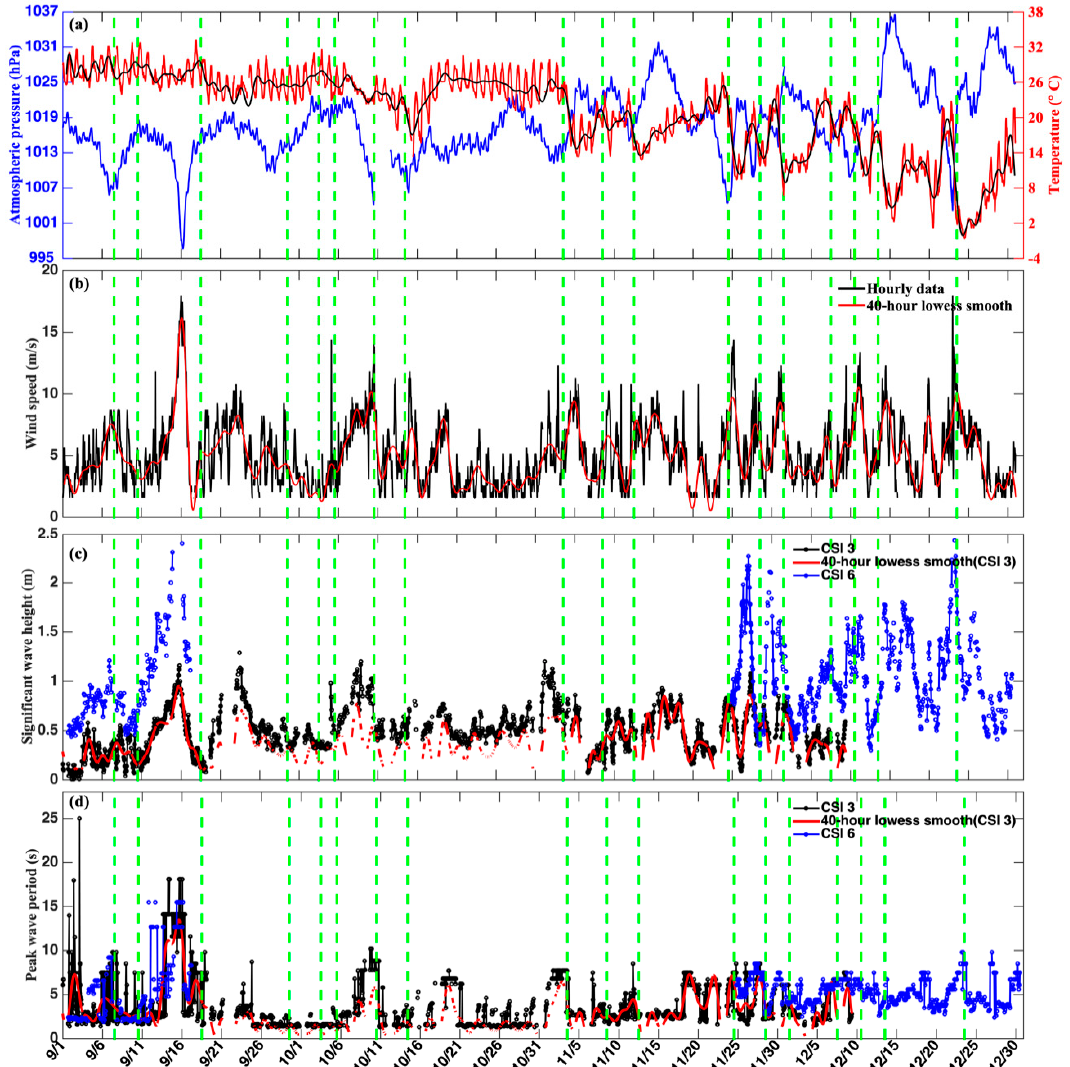
Figure 3. ( a ) Time series of the atmospheric pressure (blue line) and air temperature (red line) from the WS in Figure 1. The black line is the 40-h low pass filtered of air temperature September to December. ( b ) Wind speed (black line; unit: ms − 1 ) at WS, ( c ) significant wave height (black line for CSI 3 and blue line for CSI 6; unit: m) and ( d ) peak wave period (unit: s) from September to December. The red line is the 40-h low pass filtered data from CSI 3. The green vertical dashed lines indicate the timing of cold fronts.